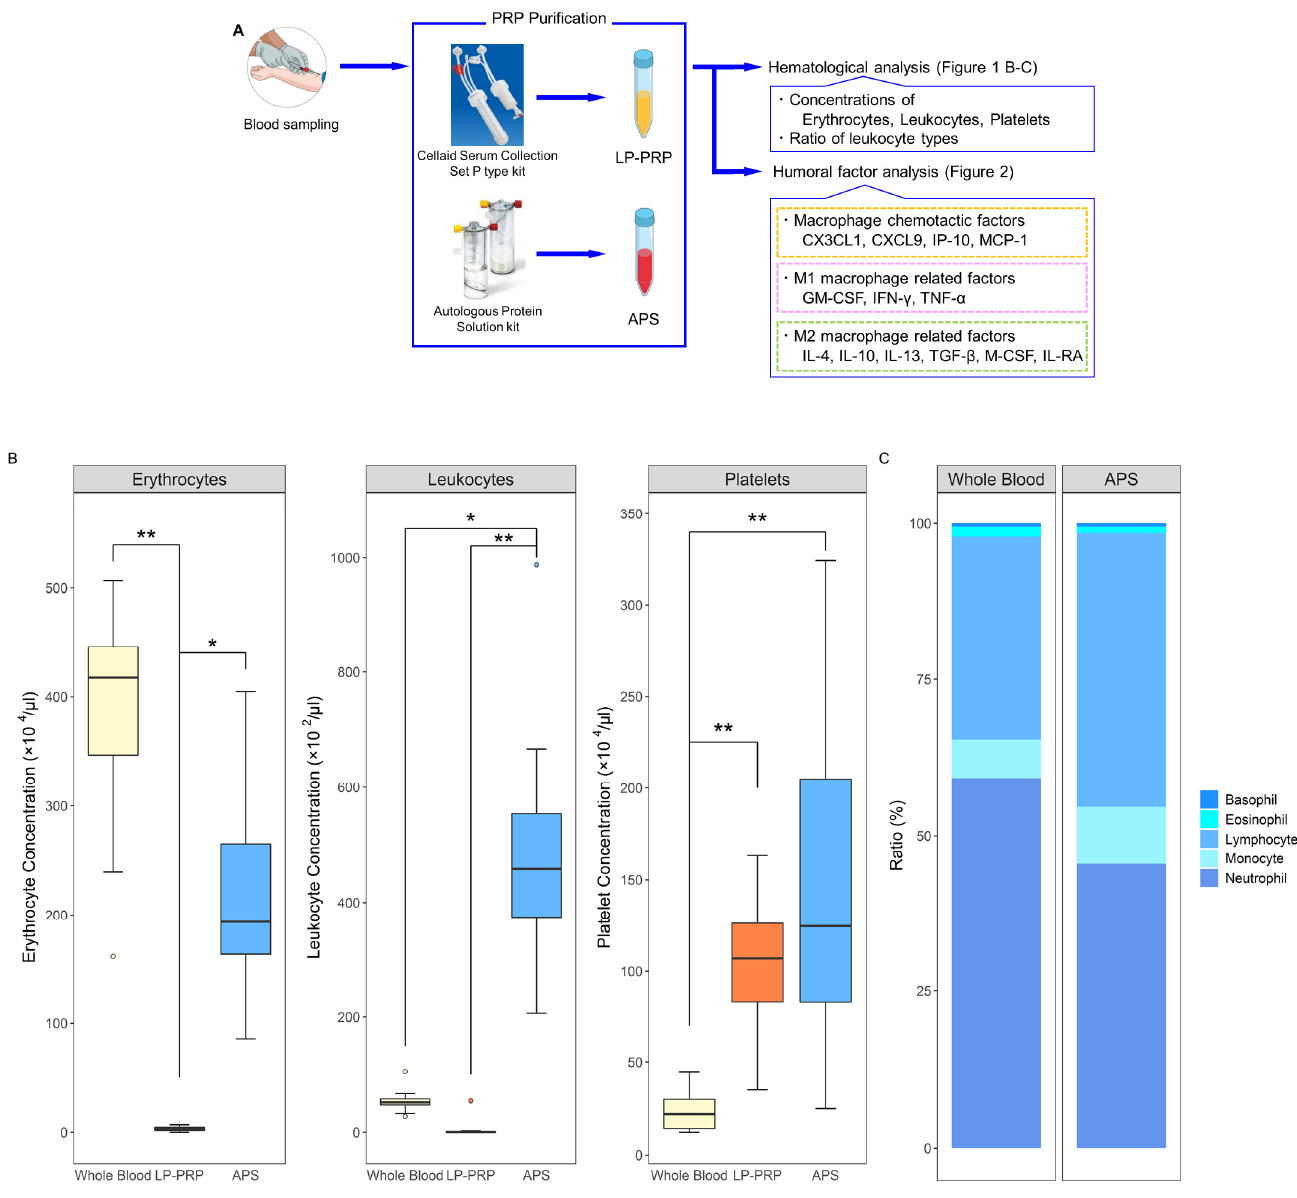
Figure 1. Purification and analyses of platelet-rich plasmas (PRPs) from two kits. ( A ) Flow of PRP purification and analyses. From each of the 12 healthy subjects, 120 mL of peripheral blood was collected and was added to 12 mL of anticoagulant citrate-dextrose solution. Leukocyte-poor PRP (LP-PRP) and Autologous Protein Solution (APS) were purified using their respective kits, and hematological analysis was performed immediately following purification. Humoral factor analysis was performed with frozen stored samples for various macrophage related factors. ( B ) Comparison of leukocyte, erythrocyte, and platelet concentrations in LP-PRP and APS. ( C ) Comparison of the ratios of leukocyte types in whole blood and APS. n = 12 PRP donors for each kit. * p < 0.05, ** p < 0.01.